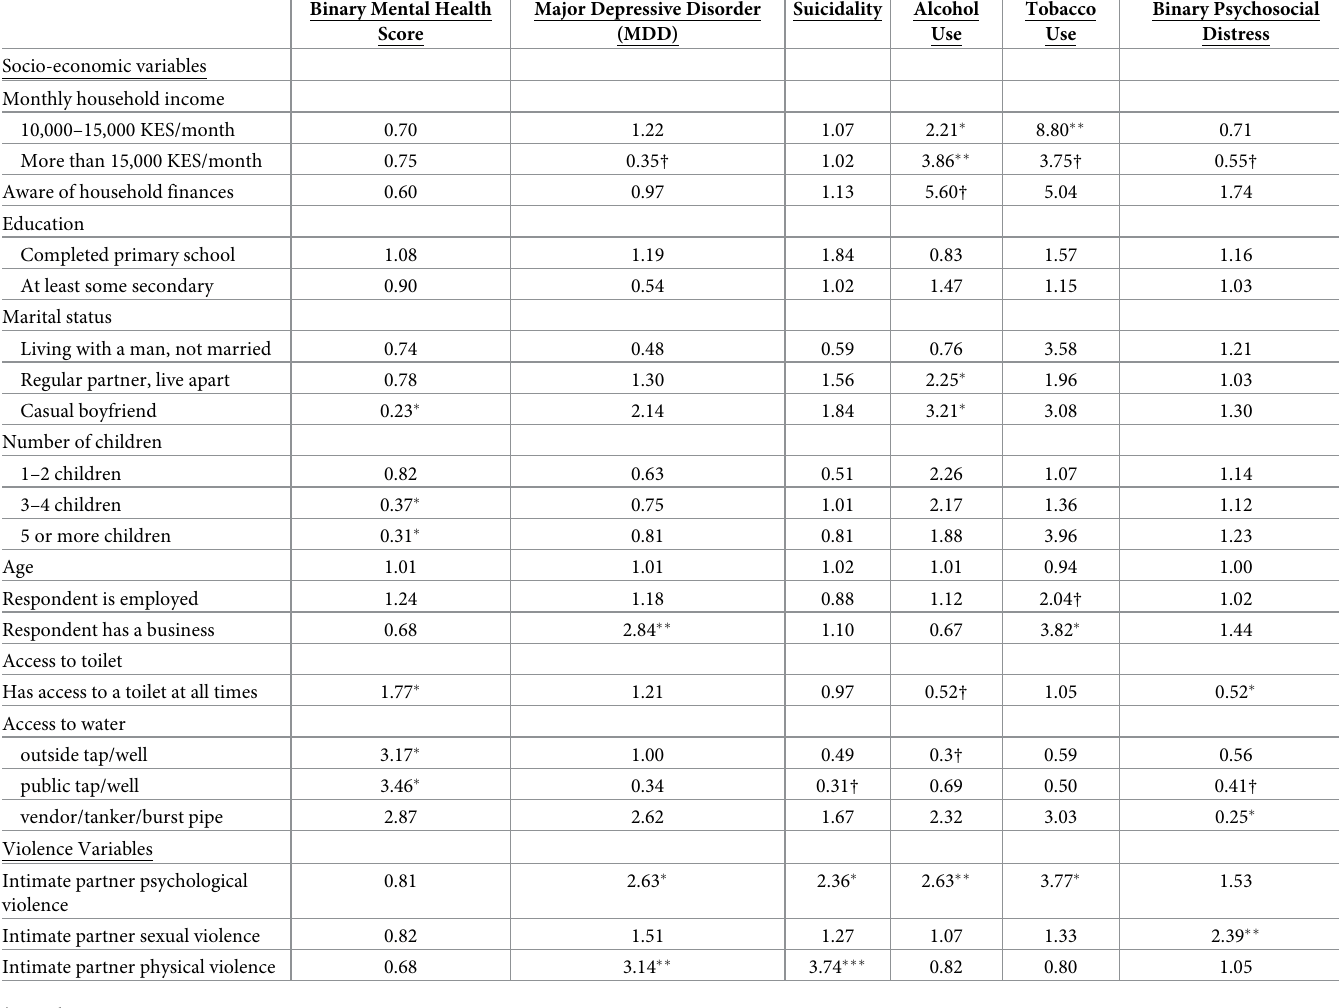
Table 2. Summary of adjusted odds ratios from logistic regression of women’s mental health on their experiences of IPV and other potential correlates and